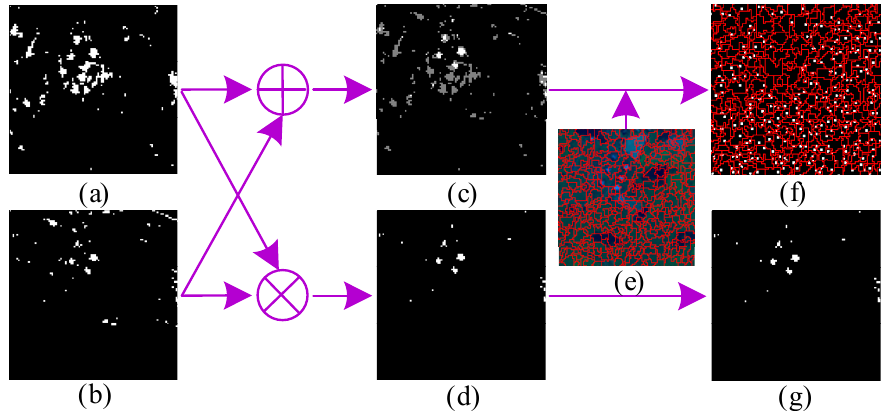
Figure 5. An example to illustrate the construction process of background and potential anomaly dictionaries on the Texas Coast. Here, ( a – g ) separately indicate the coarse binary map, fine binary map, the sum of two binary maps, the product of two binary maps, superpixel segmentation result, background dictionary index map and potential anomaly dictionary index map. The symbols ⊕ and ⊗ are addition operation and multiplication operation pixel by pixel, respectively. Note that the elements whose values are “1” in ( f , g ) are employed to act as the index to select the atoms for background and potential anomaly